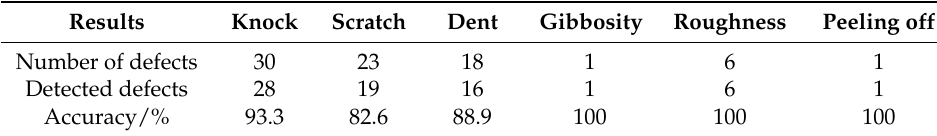
Table 3. Lateral surface inspection of gear A 4 .